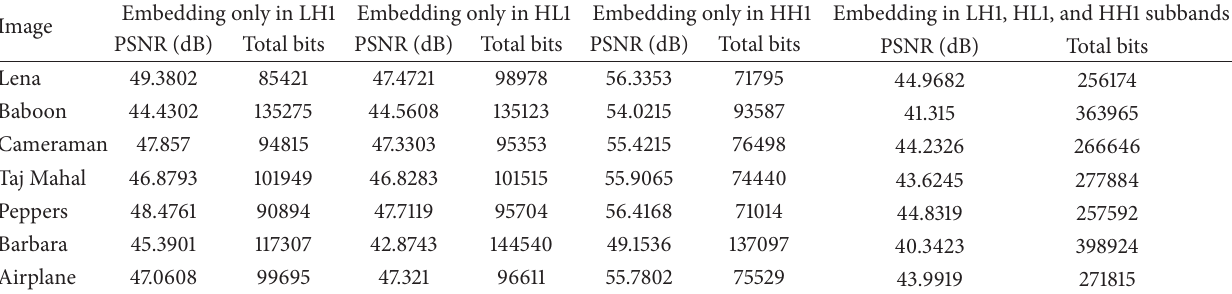
Table 2: Results for various